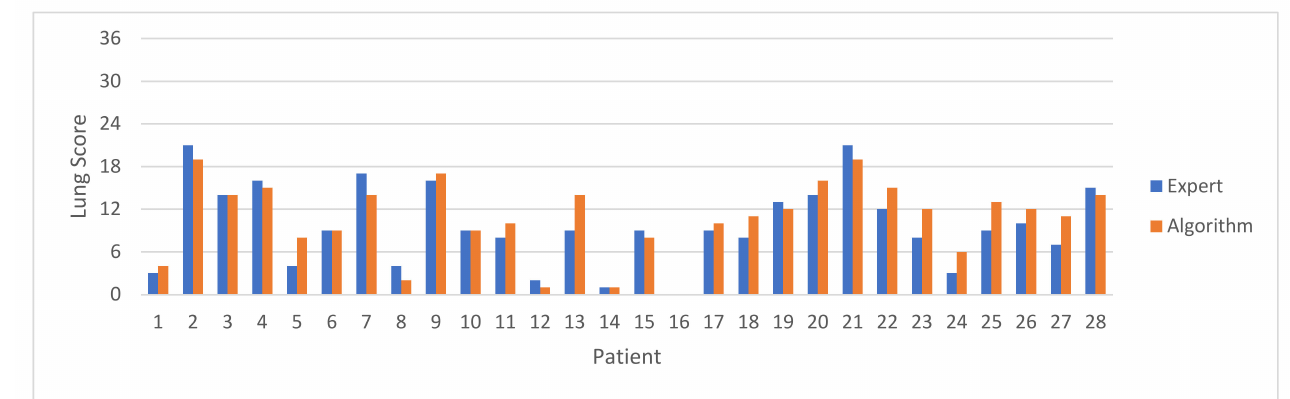
Figure 4. Lung score calculated from the expert findings (blue) and from the algorithm output (orange). In patient 16 the score was 0 for the expert and the algorithm.